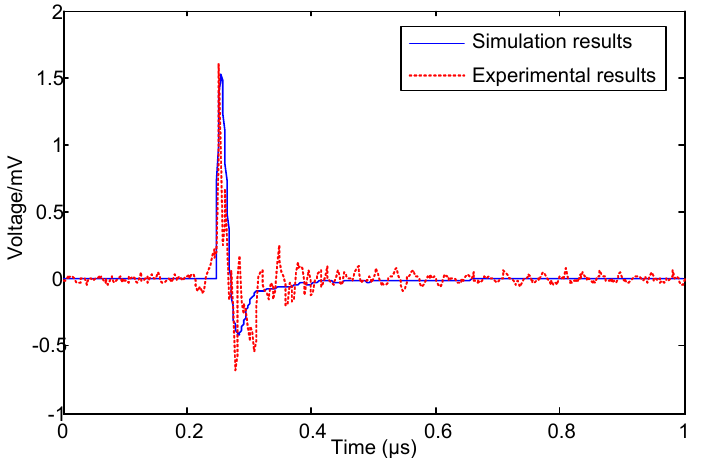
Figure 4. Comparison of the partial discharge (PD) current between the simulation and experiment as a response to 1.2 PDIV with 10 mm needle-sphere electrode configuration.